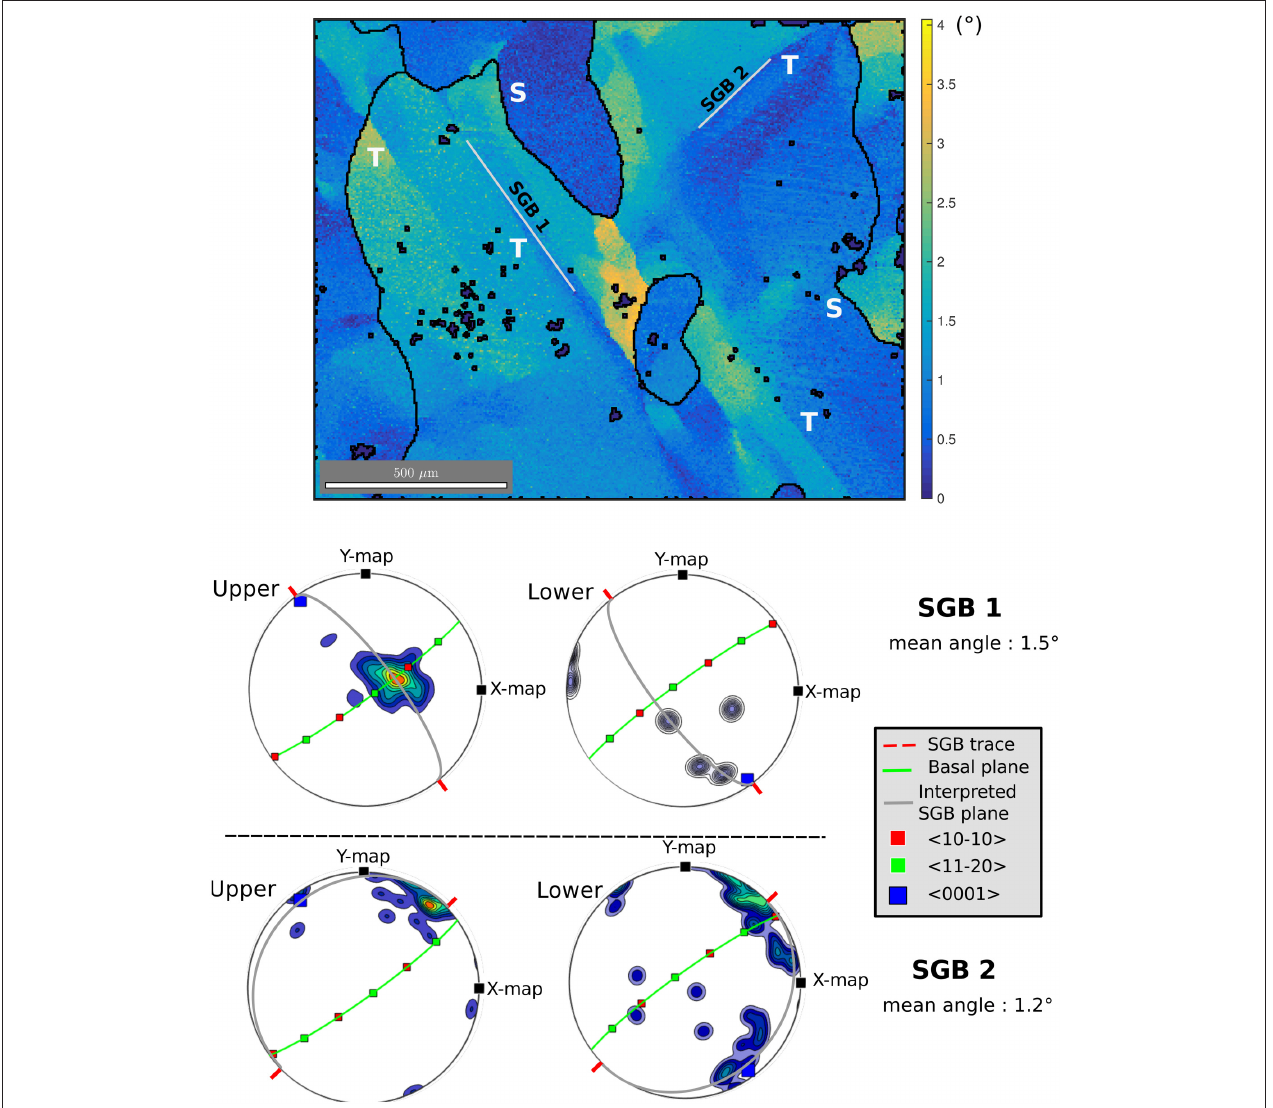
FIGURE 7 | Top: High resolution (5 µ m) observation of lattice misorientations at a triple junction in the sample deformed at 13% strain. Misorientation amplitudes compared to the average orientation of the grain (Mis2mean) are given by the color-scales in ◦ . The white lines indicate two perpendicular subgrain boundaries (SGB1 and SGB2). Bottom: Axis of rotation of the misorientation measured side by side of each subgrain boundary (SGB1 and SGB2). Rotation axes are a combination of m- and a-axes for SGB1 (top) , a-axis with a slight component of c-axis for SGB2 (bottom) . The boundary plane traces are marked in red. Tilt bands would require the boundary to be perpendicular to the sample surface for SGB1 (marked in gray), and nearly parallel to this surface for SGB2. “S” stands for “Serrated GB” and “T” for tilt